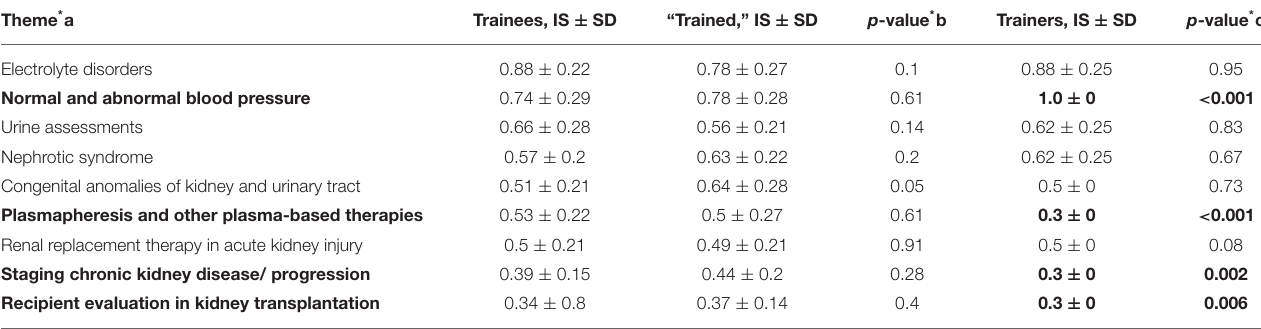
TABLE 4 | Comparison of importance scores (IS) between trainees, “trained,” and trainers. Theme *